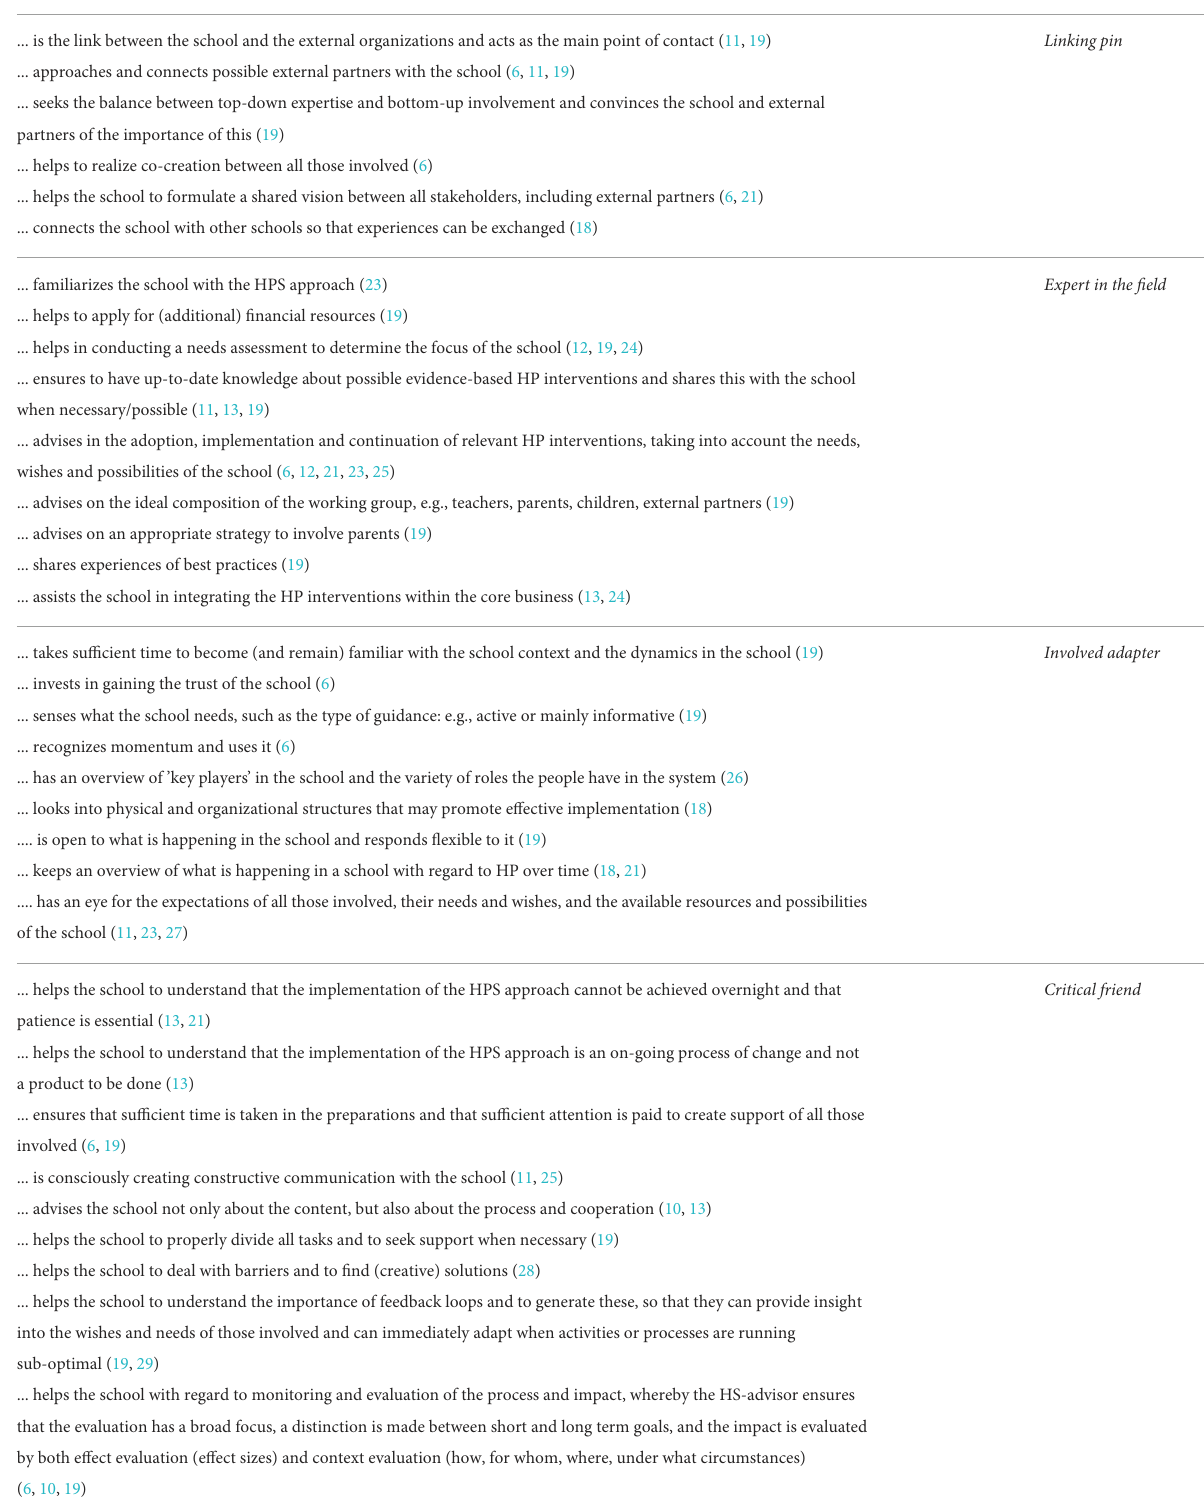
TABLE 1 From tasks to identified roles of an HS advisor: A narrative review. Tasks of an HS advisor, retrieved from scientific literature The HS advisor